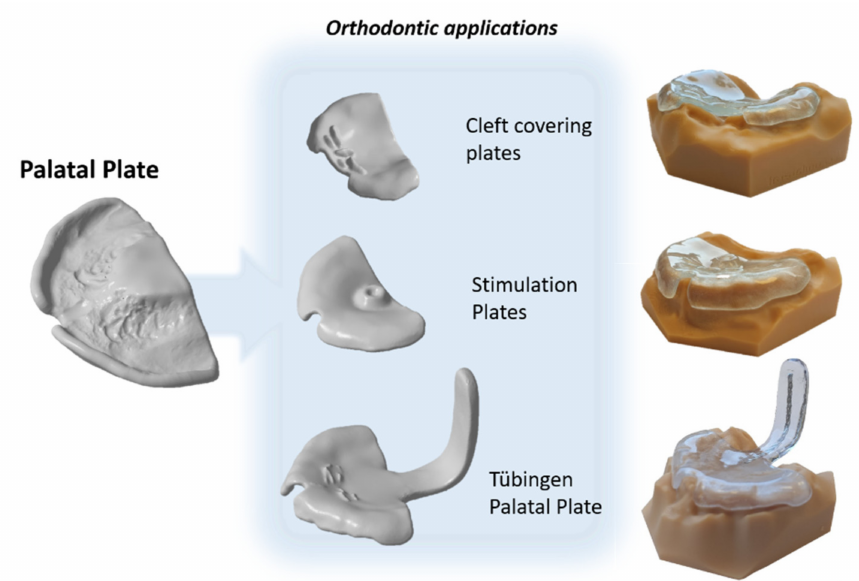
Figure 1. Digital palatal plate orthodontic applications: Cleft palatal plate, stimulation plate, Tübin- gen Palatal Plate (TPP). Digital files as well as the additively manufactured appliances on their respective model are